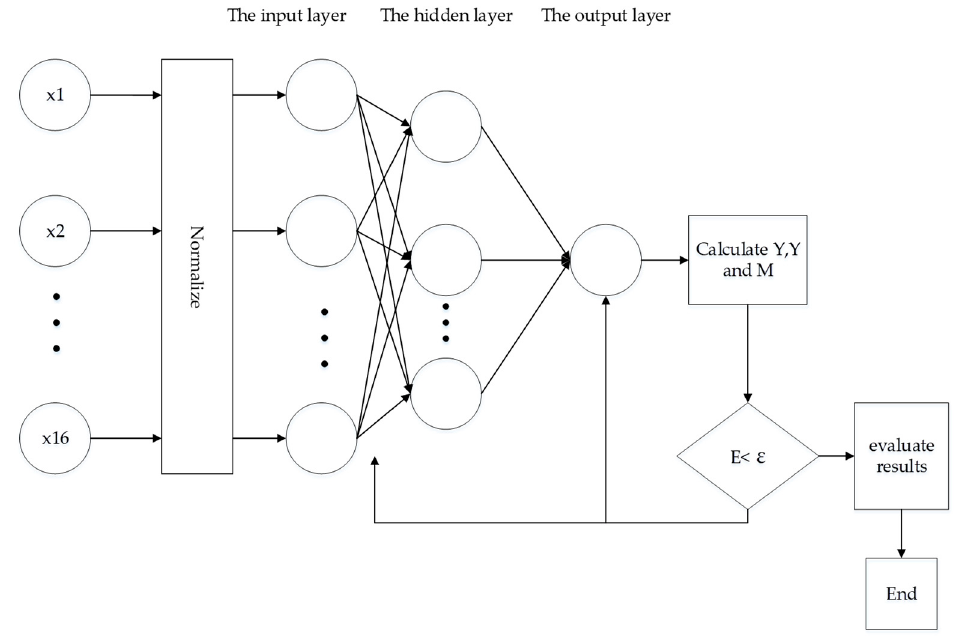
Figure 5. The construction of the BP model.